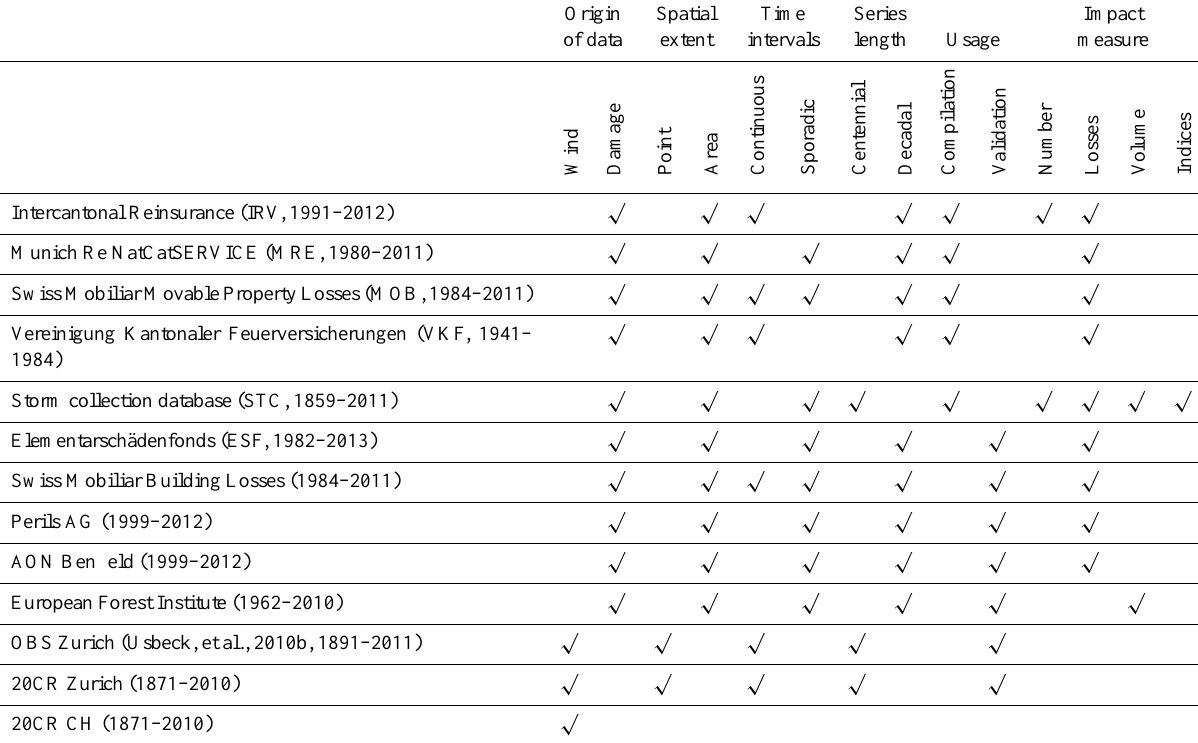
Table 1. Properties and considered time periods of sources